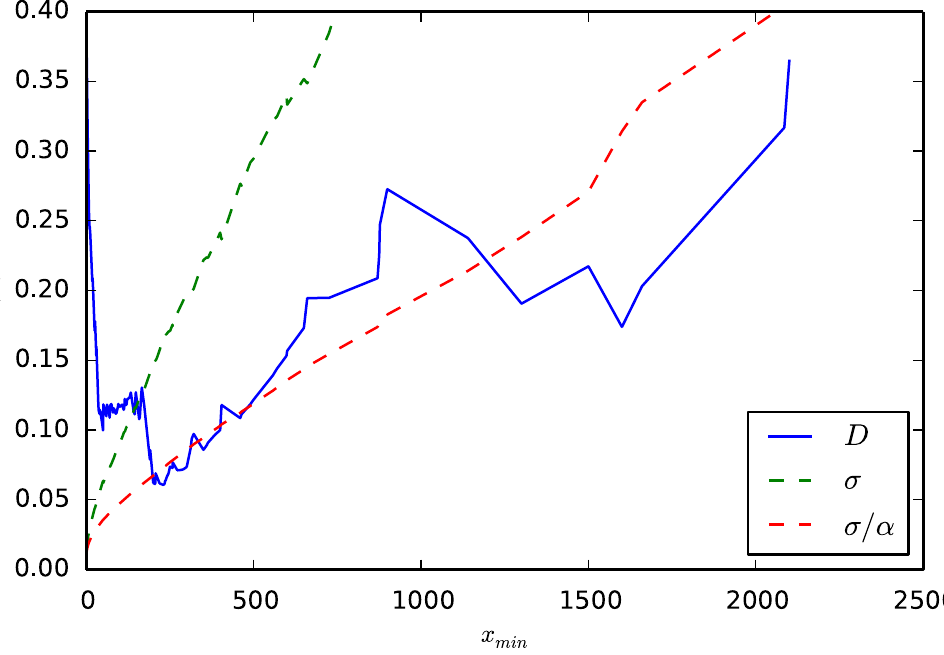
Figure 5. Example of multiple local minima of Kolmogorov-Smirnov distance D across x min . As a power law is fitted to data starting from different x min , the goodness of fit between the power law and the data is measured by the Kolmogorov-Smirnov distance D , with the best x min minimizing this distance. Here fitted data is the population sizes affected by blackouts. While there exists a clear absolute minima for D at 230, and thus 230 is the optimal x min additional restrictions could exclude this fit. Parameter requirements such as s v : 1 or s = a v : 05 would restrict the x min values considered, leading to the identification of a different, smaller x min at